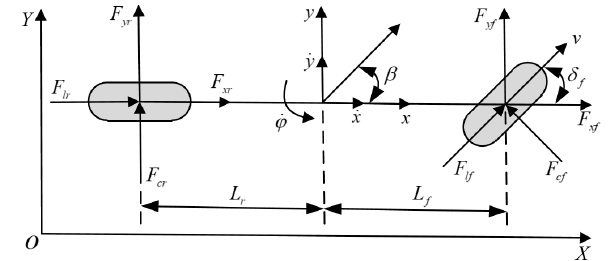
Figure 2. Schematic of the single-track vehicle model.